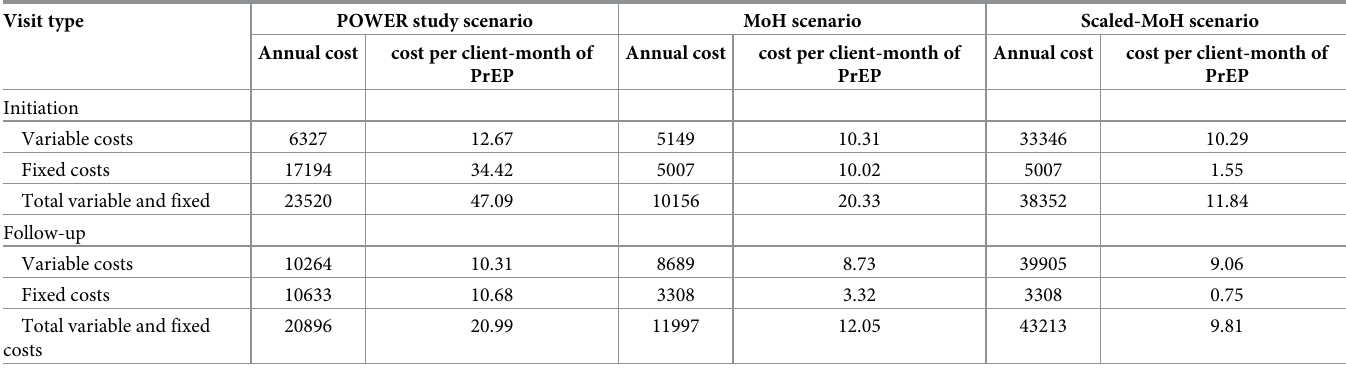
Table 3. Economic costs by visit type (2019